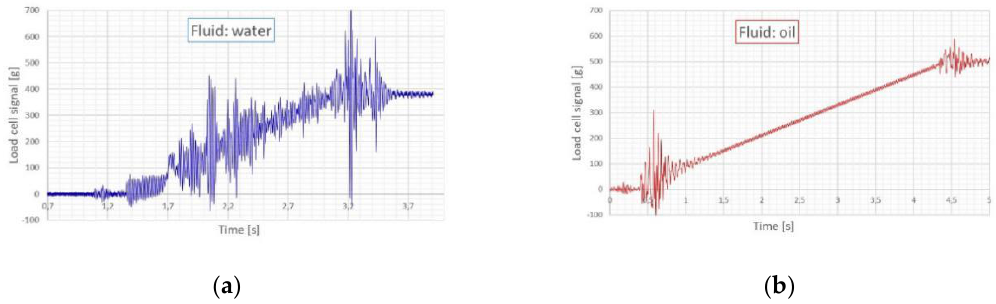
Figure 6. ( a ) Signal of the load cell of a filling system with water as fluid. ( b ) Signal of the load cell of a filling system with oil as fluid.